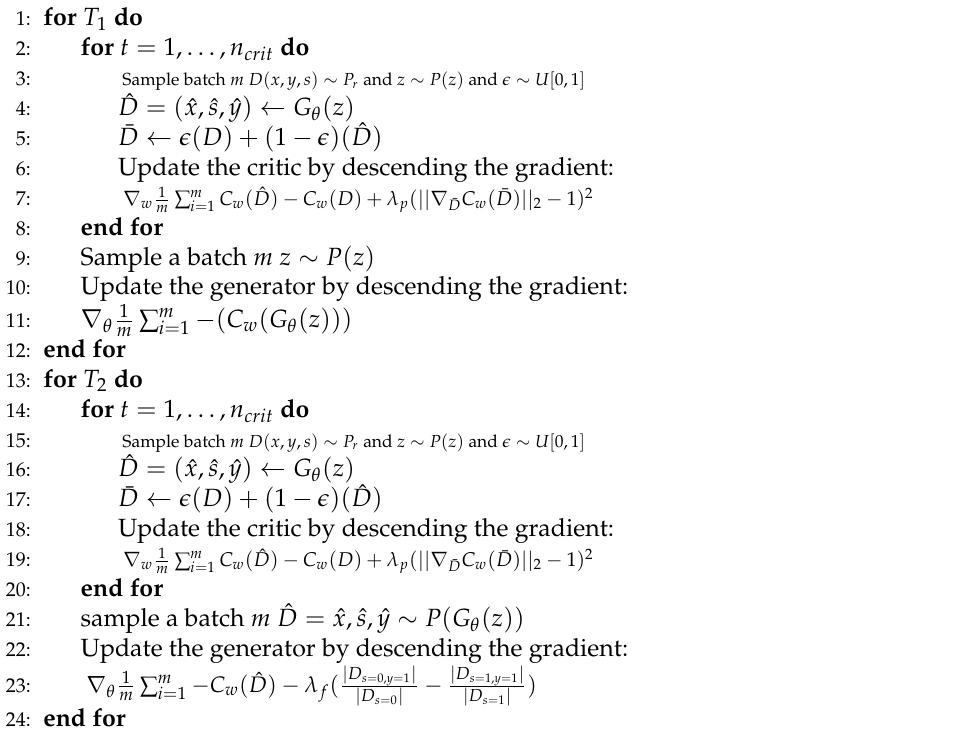
Algorithm 1 training algorithm for the proposed WGAN. We use n crit = 4, batch size of 256, λ p = 10, Adam optimizer with α = 0.0002, β 1 = 0.5, and β 2 =